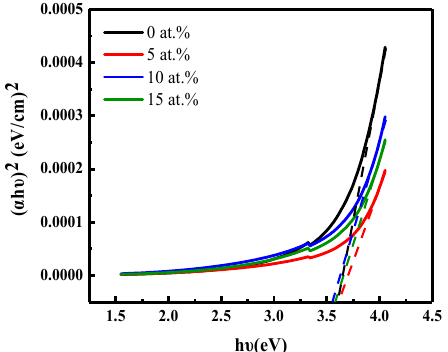
Figure 4. The ( α h υ ) 2 versus h υ plots of SnO 2 :Si films for di ff erent doping concentrations. Figure 4. The (α ℎ (cid:2029) ) 2 versus ℎ (cid:2029) plots of SnO 2 :Si films for different doping concentrations.